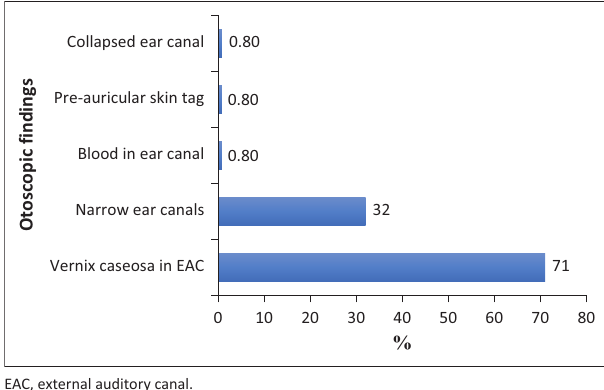
FIGURE 2: Otoscopic findings in neonates prior to hearing screening ( N =